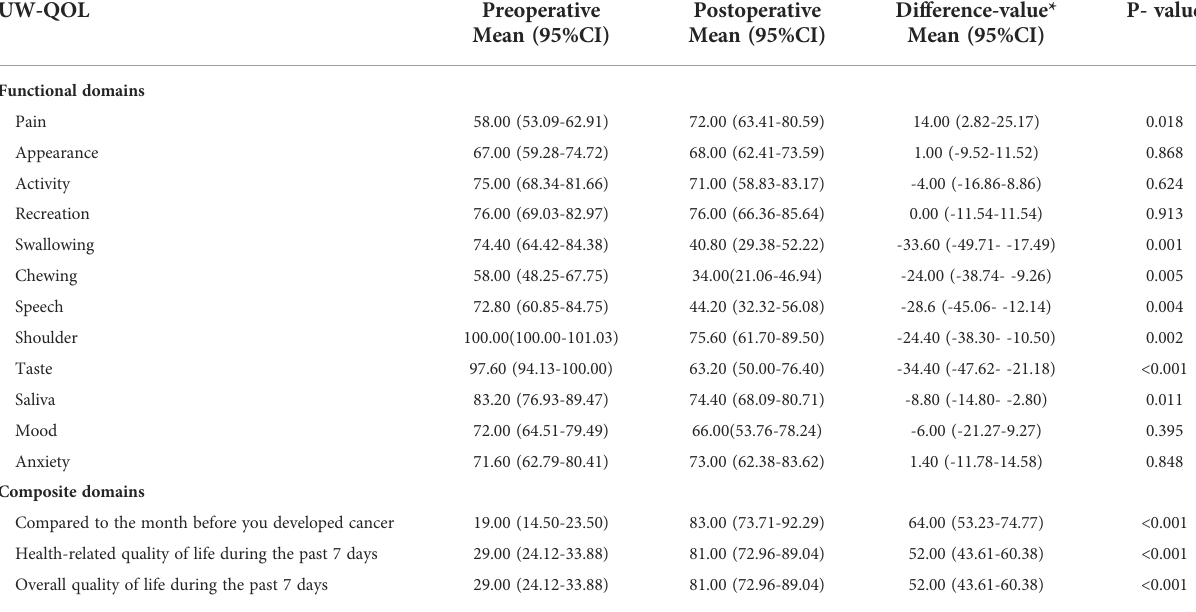
TABLE 2 Comparison of quality of life between preoperative and postoperative with UW-QOL.